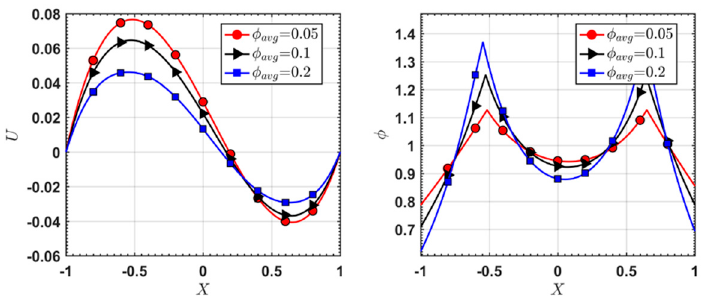
Figure 6. E ff ect of bulk (average) concentration ( φ avg ) on the velocity and concentration profiles, when Γ c = 2.5, Γ µ = 0.1, Le = 10, n = − 0.5, δ = 1, Ra = 2 and Br = 5.